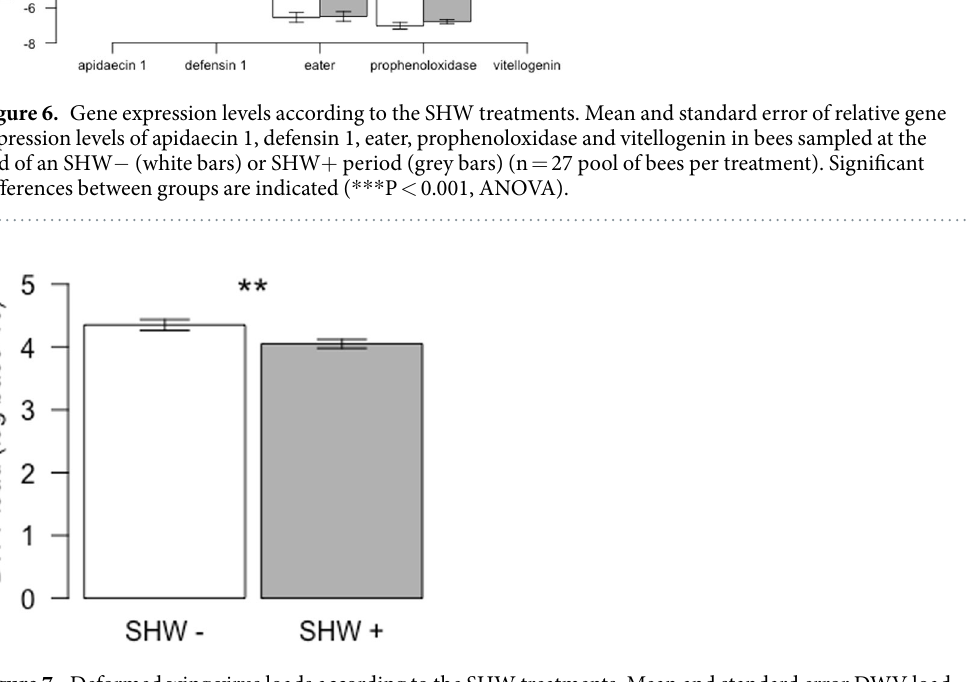
Immune gene expression and DWV loads. The gene expression levels of apidaecin 1, defensin 1, eater and prophenoloxidase were not affected by SHW (P > 0.17 for all genes; Fig. 6). However, vitellogenin expression levels significantly increased with SHW treatment (P < 0.001; Fig. 6 and Supplementary Fig. S3). All colonies were DWV-positive, and we observed a significant decrease in DWV loads after exposing a colony to SHW (P = 0.003; Fig. 7 and Supplementary Fig. S4). Furthermore, a significant negative correlation between DWV loads and vitel- logenin levels was detected before the SHW treatments (cor = − 0.42, P = 0.034), but this correlation disappeared after the SHW treatments (cor = 0.045; P = 0.83).